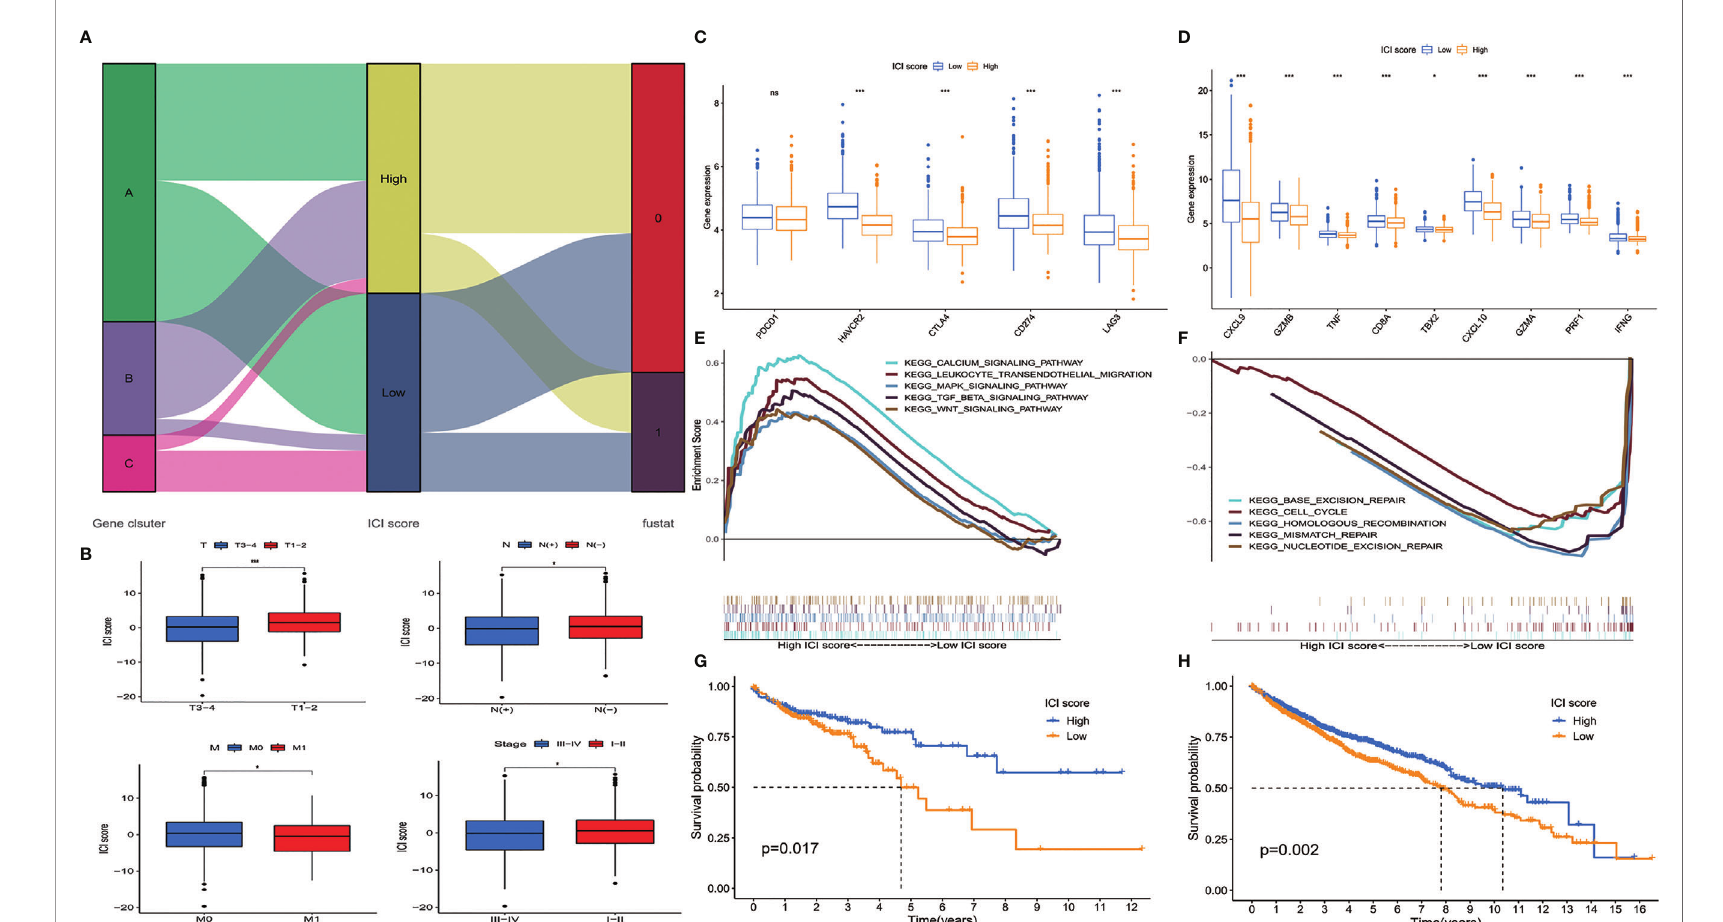
FIGURE 3 | Construction of immune cell in fi ltration (ICI) score model. (A) Alluvial diagram of patient distribution. (B) ICI scores of patients in different subgroups (mean ± SD, Kruskal – Wallis test, * p < 0.05; *** p < 0.001). (C) Immune-checkpoint associated genes ( PDCD1 , HAVCR2 , CTLA4 , CD274 , and LAG3 ) and (D) immune-activity associated genes ( CXCL9 , GZMB , TNF , CD8A , TBX2 , CXCL10 , GZMA , PRF1 , and IFNG ) expressed in ICI high and low groups (mean ± SD, Kruskal – Wallis test, * p < 0.05; *** p < 0.001). (E) Gene set enrichment analysis (GSEA) showed that calcium signaling pathway, leukocyte transendothelial migration pathway, MAPK signaling pathway, TGF b pathway, and Wnt signaling pathway were enriched in high ICI score group. (F) Base excision repair pathway, cell cycle pathway, homologous recombination pathway, mismatch repair pathway, and nucleotide excision repair pathway were enriched in low ICI score group. (G) Overall survival of colon cancer patients in ICI high and low groups in the Cancer Genome Atlas (TCGA) cohort (log-rank test, p = 0.017). (H) Overall survival of colon cancer patients in ICI high and low groups in the total patient cohort (log-rank test, p = 0.002; ns, non signi fi